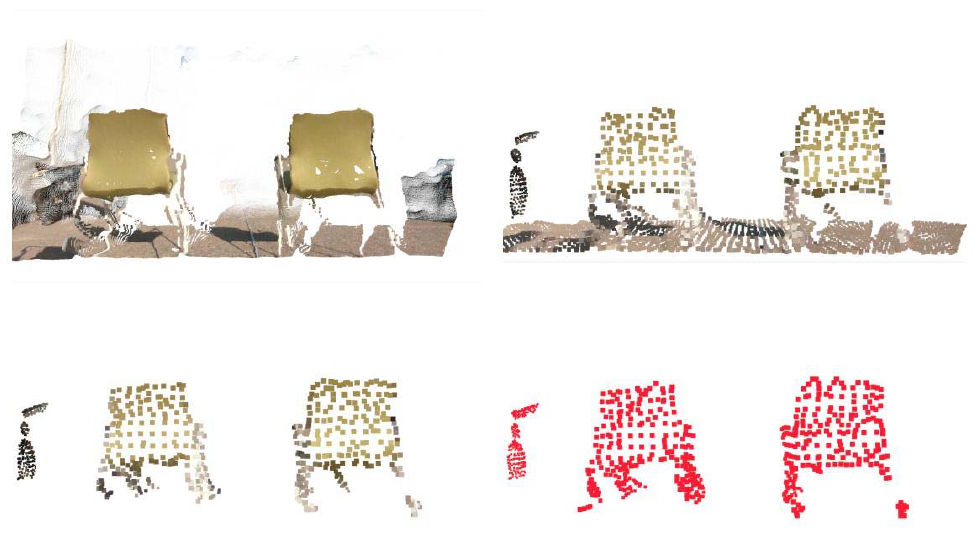
Figure 4. Outdoor results for the four stages of processing.